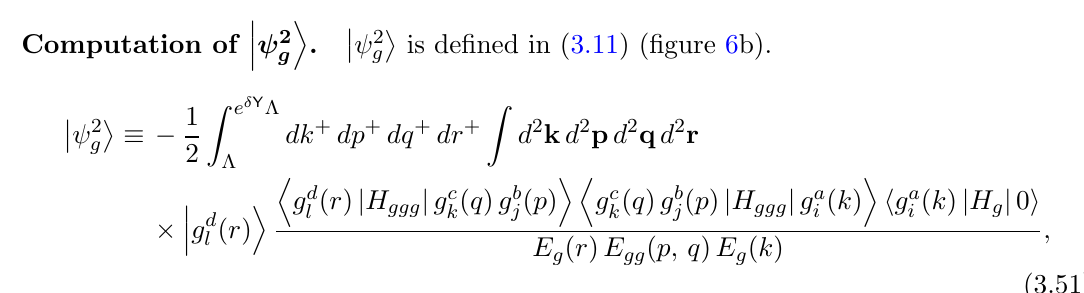
(cid:12) (cid:12) (cid:11) (cid:11) , (b) - (cid:12) 1 g (cid:12) 2 g